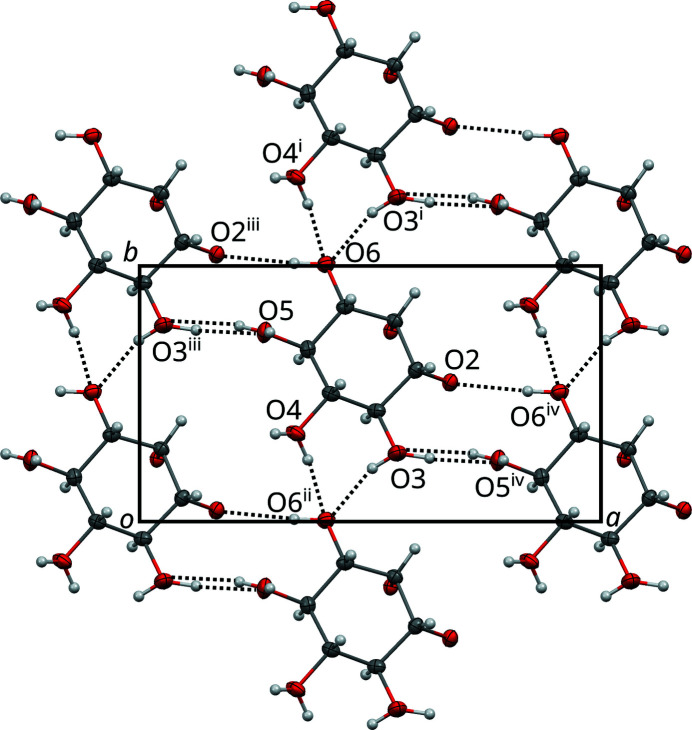
Disordered hydrogen-bonding network in the I half-layers of 1 projected on the layer plane (001). Hydrogen bonds are indicated by dotted lines. Hydroxyl groups featuring two H atoms are disordered in a 1:1 manner. Hydrogen atoms without apparent acceptor connect across half-layers. The bornane atoms of the adjacent B layers are not shown. Symmetry codes: (i) t(0,1,0); (ii) t(0,−1,0); (iii) t(−½,½,0); (iv) t(½,−½,0). Atom colors as in Fig. 4 ▸.